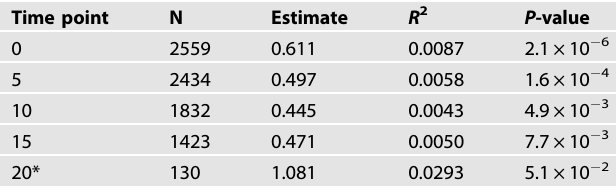
Fig. 3 Adjusted trajectories of general cognitive function for the APOE haplotype groups. This fi gure shows the adjusted trajectories of general cognitive function for three APOE groups (i.e. ɛ 2 carriers, ɛ 3 homozygotes and ɛ 4 carriers) up to 20-years follow-up ( n = 2559). T0-T20 represents time in years. The trajectories were adjusted for sex, age at baseline, and population strati fi cation using the fi rst two gPCs. In addition, we included time (0 – 20 years with 5-year intervals, i.e. fi ve time points) into the model, and the interaction terms SNP*time and age at baseline*time. Table 3. R² between the polygenic pro fi le score and general cognitive function per time